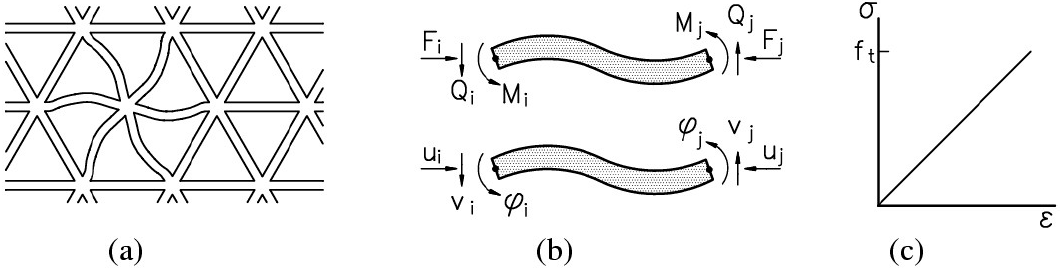
Figure 4. Lattice of beam elements ( a ); definition of forces and degrees of freedom ( b ); stress-strain relation of beam element ( c ).